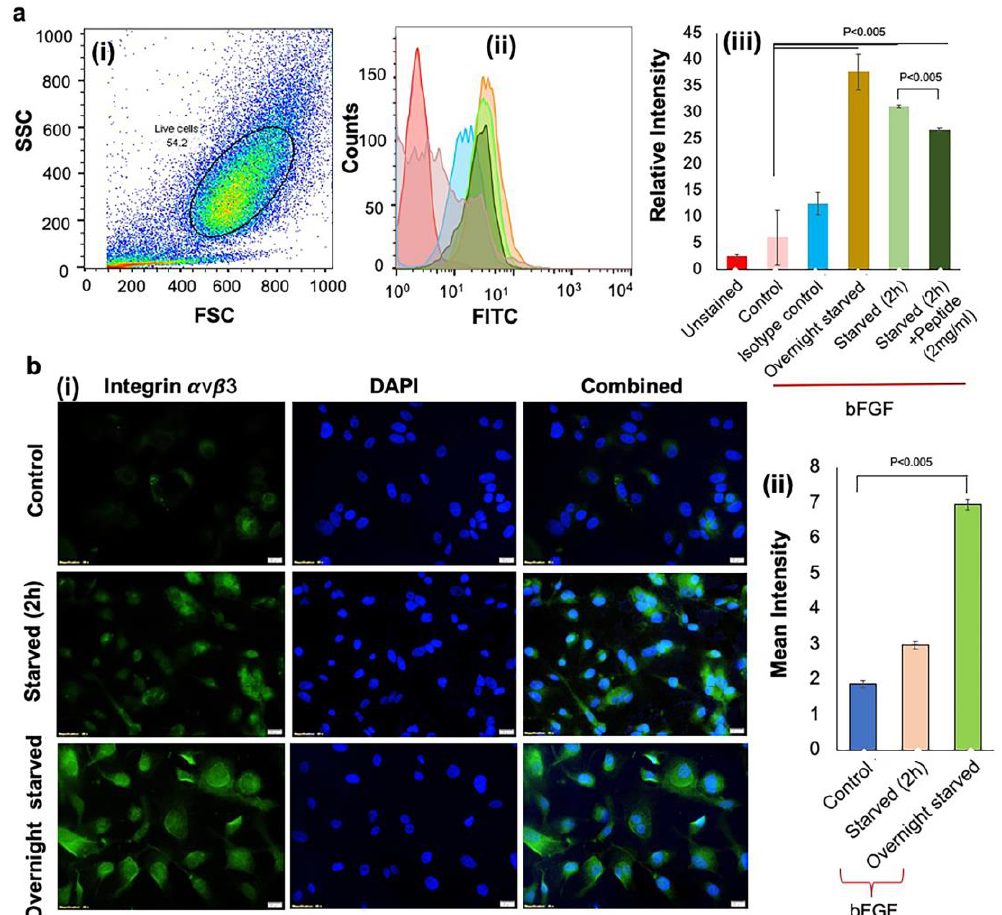
Figure 3. Expression of α v β 3 by HUVECs under di ff erent conditions ( a ) Flow cytometry analysis demonstrated significant expression of integrin α v β 3 in overnight starved cells. (i) Side scatter (SSC) vs. forward scatter (FSC) plot used to gate live cells and resulting (ii) histograms from which α v β 3 expression was (iii) quantified for di ff erent culture conditions. Colors in (ii) match the conditions shown in the x-axis of (iii). Values were expressed as mean ± SD, n = 3. p < 0.005 was considered significant. ( b ) Immunostaining was performed by (i) staining HUVECs with anti-human CD51 / CD61 antibody to detect integrin α v β 3 (green). Nuclei were stained by DAPI (blue). Integrin α v β 3 expression was highest under overnight starved conditions when compared to control and 2 h starvation. (ii) Quantification of the images in (i) obtained using Image J. Value was expressed as mean ± SD, n = 3. p < 0.05 was considered significant.